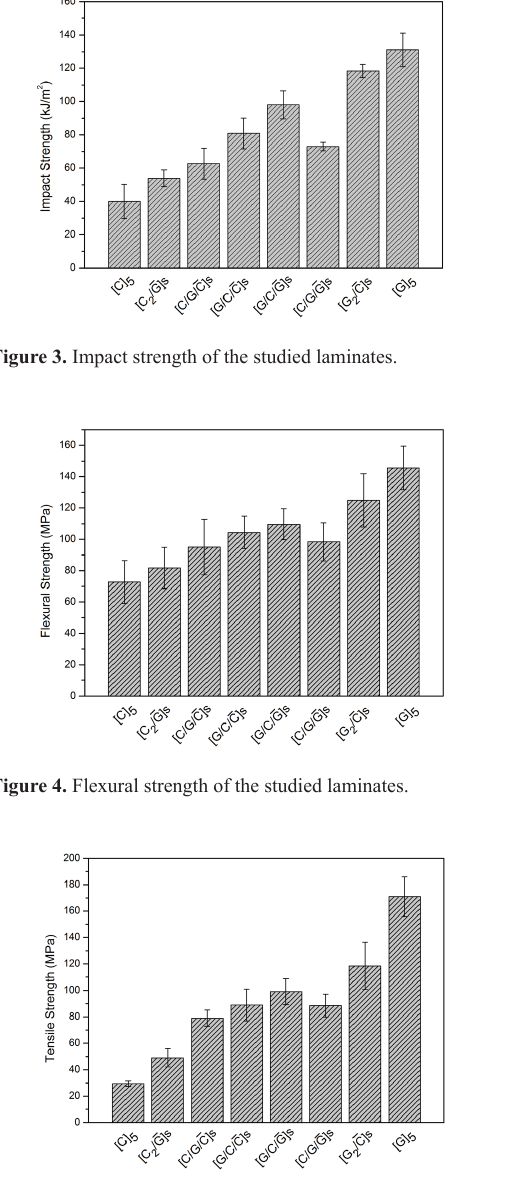
Figure 5. Tensile strength of the studied